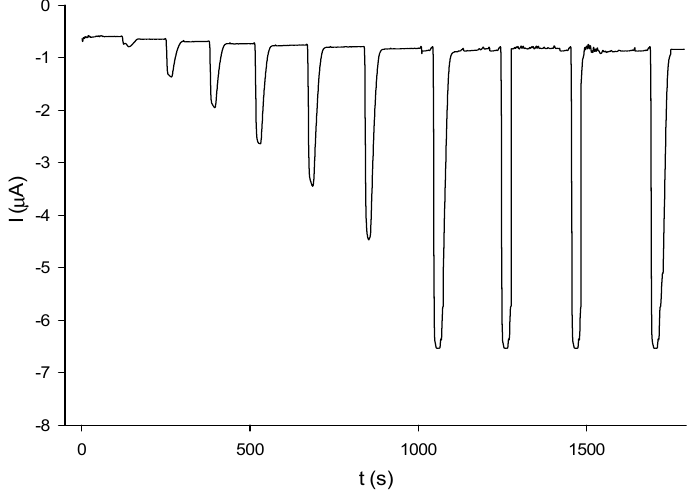
Figure 4. Chronoamperometric current response under flow injection analysis (FIA) conditions to caffeic acid in the range 0.5 μ M–1.5 mM, using MWCNTs-PVA-AuNPs- Trametes versicolor (TvL) screen-printed electrode. Experimental conditions: 0.1 M B-R buffer pH 5; flow rate: 0.716 mL/min; loop 250 μ L, E = − 0.15 V ( vs . Ag/AgCl). Table 3. Calculated kinetic parameters of laccase based biosensors for each mediator.